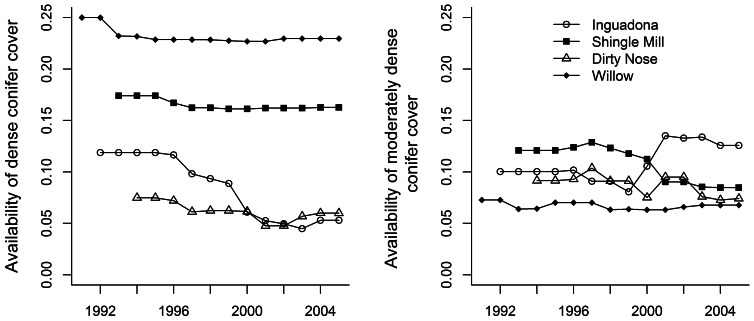
Model-based predicted probabilities of adult (≥1.5 years old), female white-tailed deer using dense (≥70% canopy closure, yellow) and moderately dense (40% ≤×<70% canopy closure, red) conifer cover, and “other” (here includes conifer with <40% canopy closure, openings, and hardwoods; blue) during daytime hours (i.e., 0730–1700 hr) as a function of snow depth (panels A-D) and minimum daily temperature (panels E-H), for each of four study sites, north-central Minnesota, 1 November–14 May 1993–1994 to 2004–2005.Colored bands depict point-wise 95% bootstrap confidence intervals. To generate model-based response curves, we set availabilities of each habitat type to site-specific mean values. Similarly, we set daily snow depths (for bottom panels) and minimum temperatures (for top panels) to site-specific means.